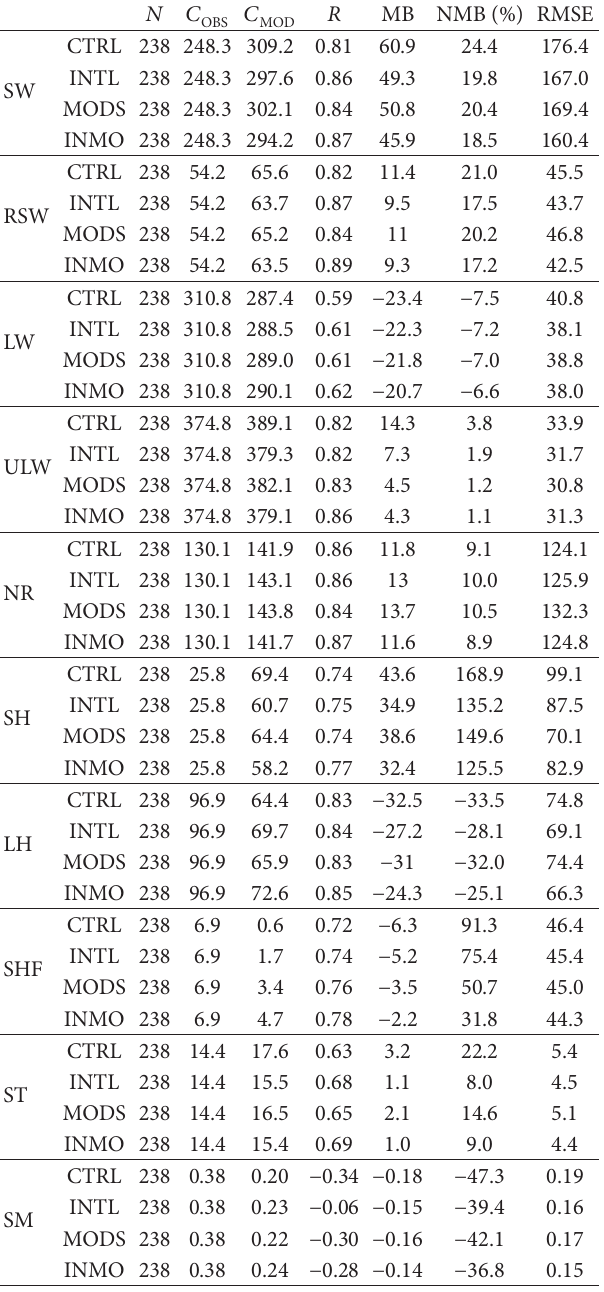
Table 3: Statistics of surface radiation (SW (wm 2 ), RSW (wm 2 ), LW (wm 2 ), and ULW (wm 2 )), surface energy (NR (wm 2 ), SH (wm 2 ), LH (wm 2 ), and SHF (wm 2 )), and soil temperature and moisture (ST ( ∘ C) and SM (m 3 m −3 )) between the observation and model results